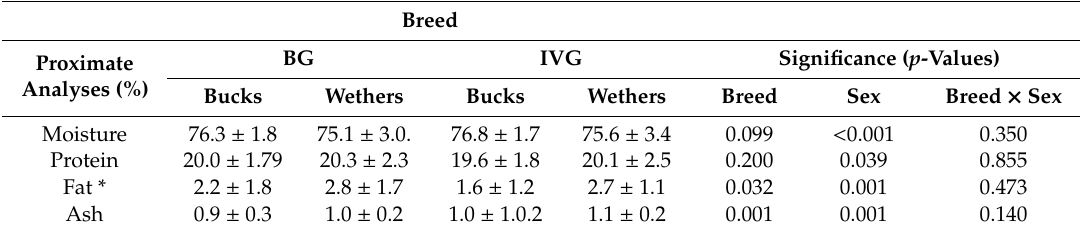
Table 3. Least-square means and standard error (SE) for the chemical composition of the loins of Boer and large frame Indigenous Veld buck and wether